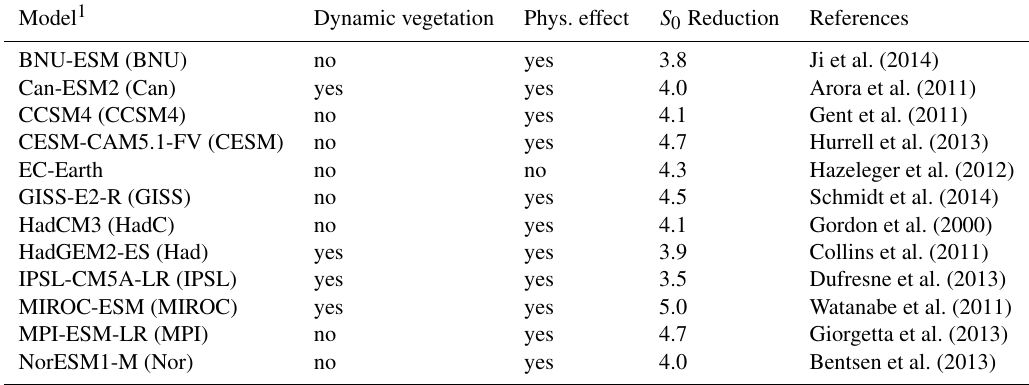
Table 1. GeoMIP model specifications. In certain figures, the models are labeled with the shortened name in parentheses. Column 3 refers to the CO 2 physiological effect in plants. The solar constant ( S 0 ) reduction is a percentage. Information courtesy of Kravitz et al.